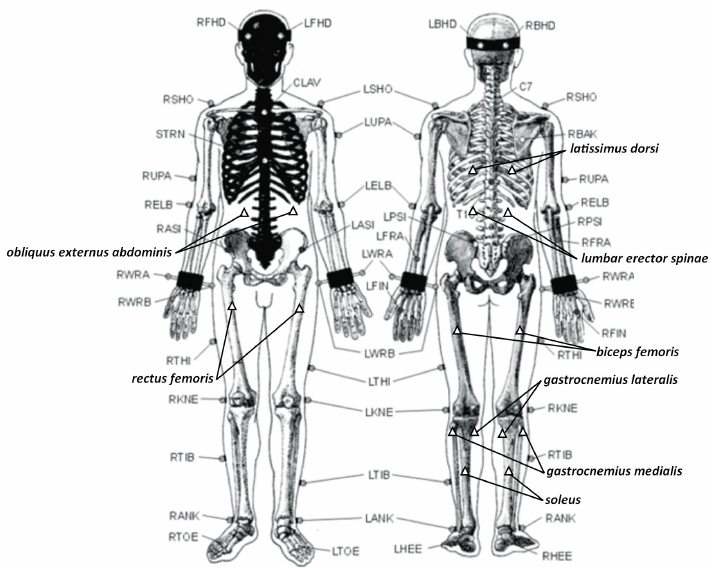
Figure 2. The placement of 39 motion capture markers and EMG electrodes on the nurse. The same scheme was used for the patient (without the EMGs). Skeleton schema as well as marker abbreviations of the marker names sources: http://www.lifemodeler.com/LM_Manual_2010/A_motion.shtml, accessed on 1 April 2021.